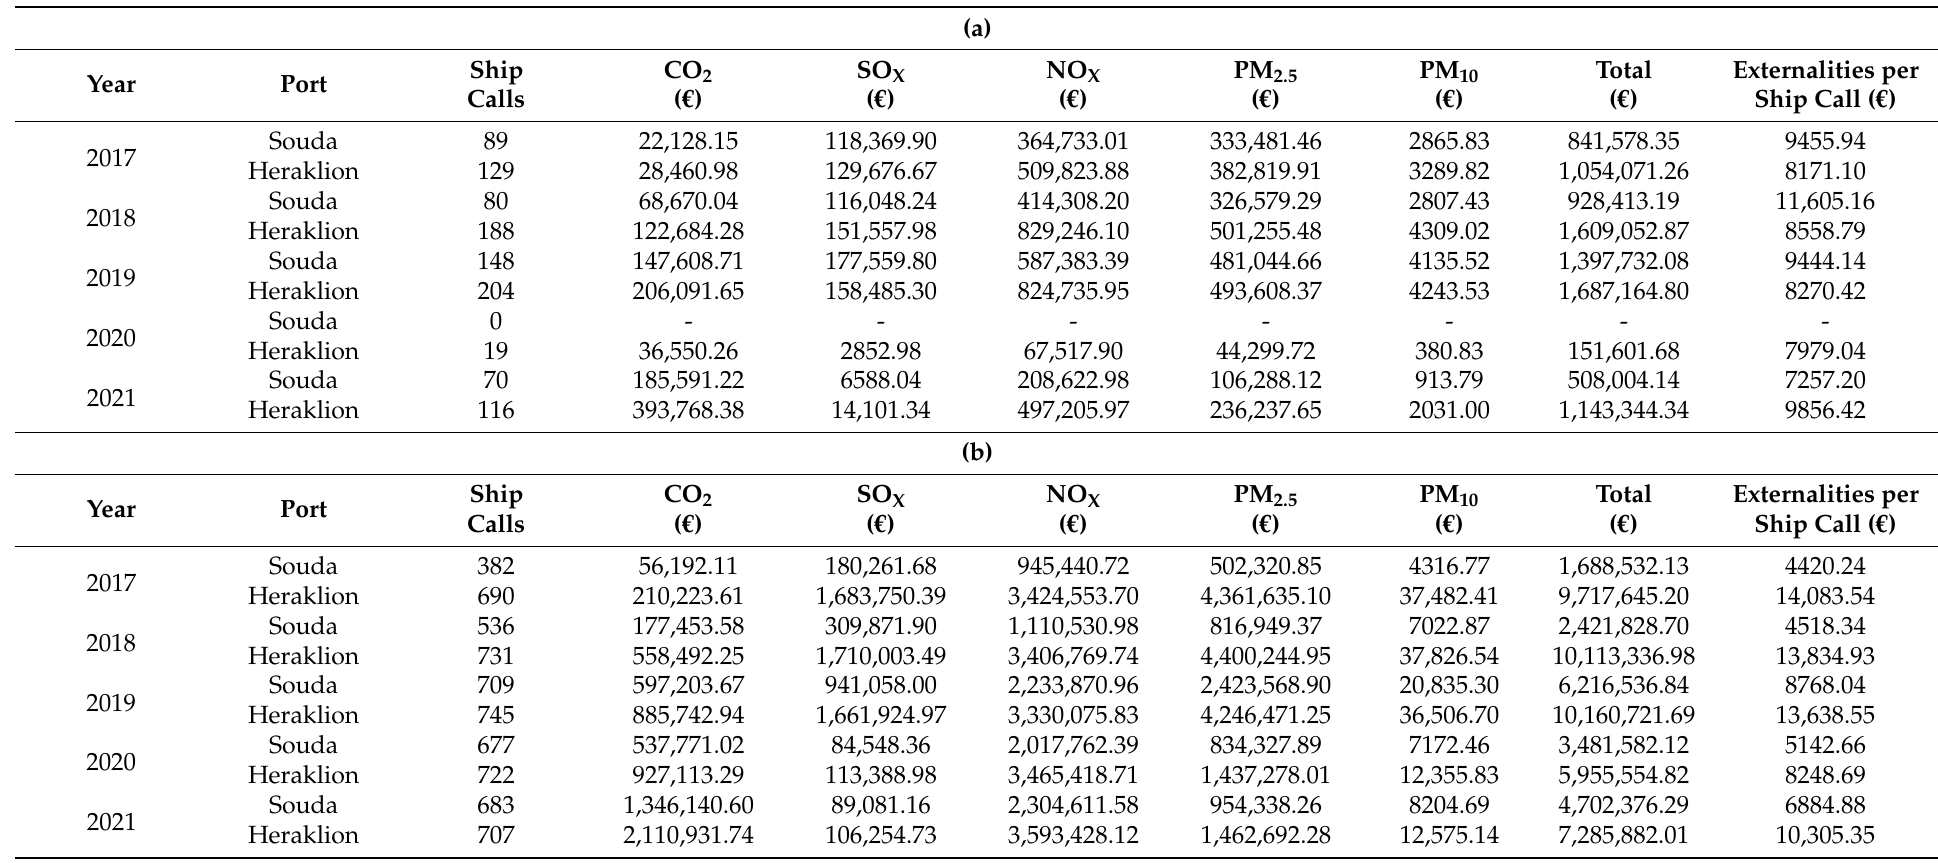
Table 6. (a) Air emissions externalities for cruise sector of ports Souda and Heraklion. (b) Air emissions externalities for passenger ferries of ports Souda and